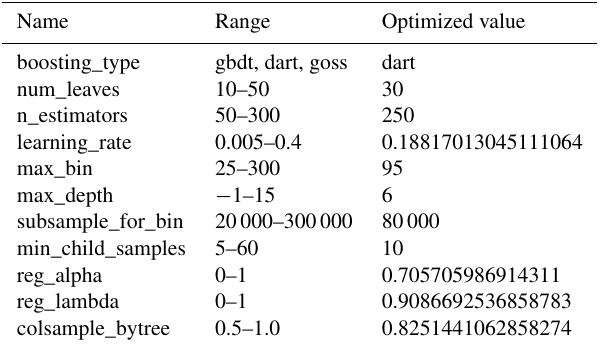
Table A2. LightGBM hyperparameters that underwent Bayesian optimization and their final optimized values. See Sect. 2.2.1 for further discussion on the variable processing. See Pedregosa et al. (2011) documentation for further discussion about each hyperpa-